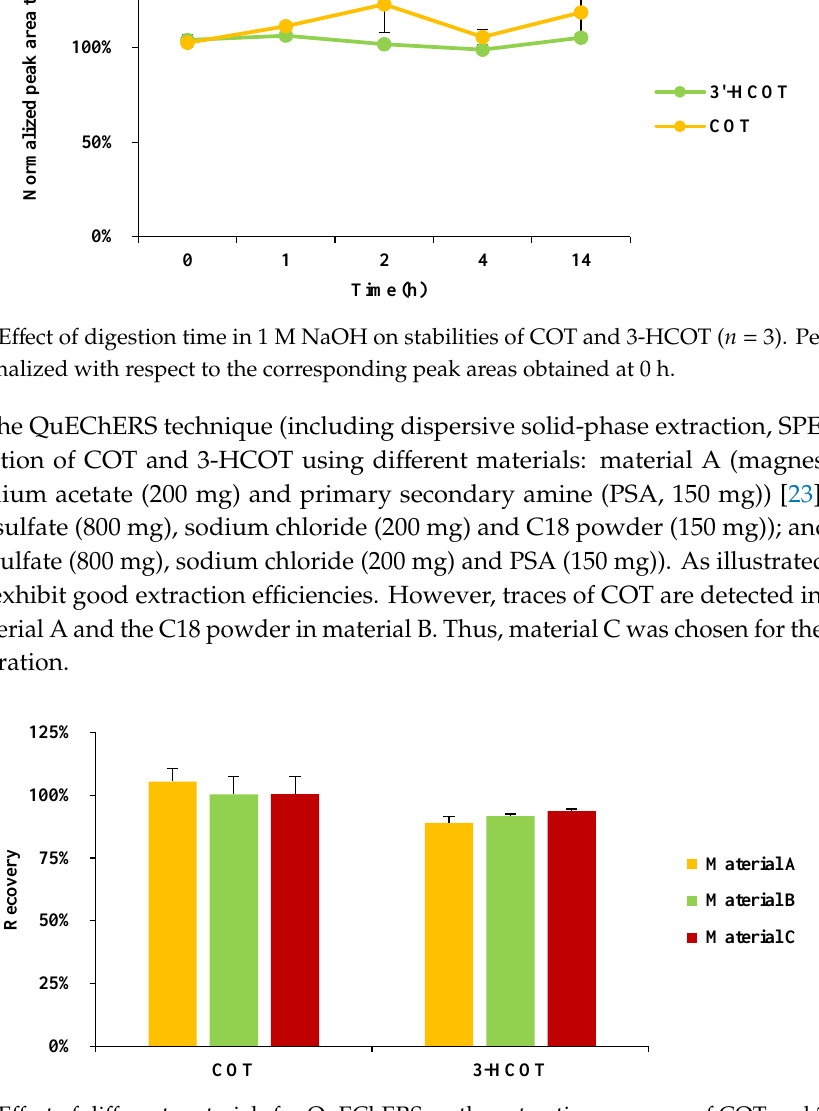
Figure 2. Effect of different materials for QuEChERS on the extraction recovery of COT and 3-HCOT ( n = 3): material A (magnesium sulfate (800 mg), sodium acetate (200 mg) and primary secondary amine (PSA, 150 mg)); material B (magnesium sulfate (800 mg), sodium chloride (200 mg) and C18 powder (150 mg)); and material C (magnesium sulfate (800 mg), sodium chloride (200 mg) and PSA (150 mg)).